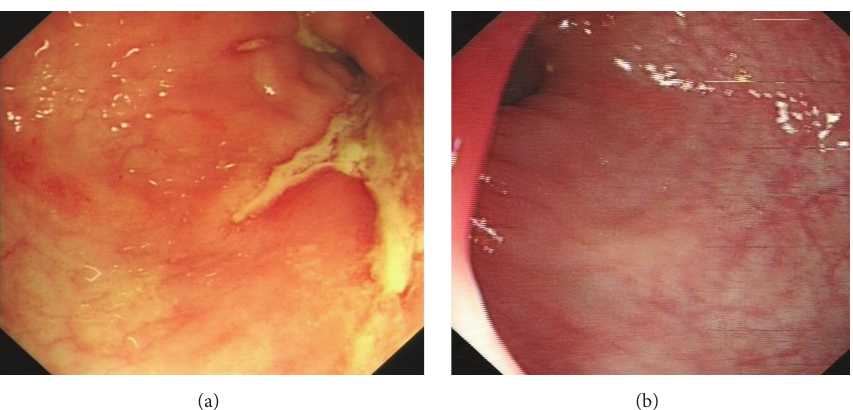
Figure 1: (a) Ulcer in the sigmoid colon before treatment of one case in the IFX treatment group; (b) sigmoid colon 30 weeks after treatment (no ulcer is seen).